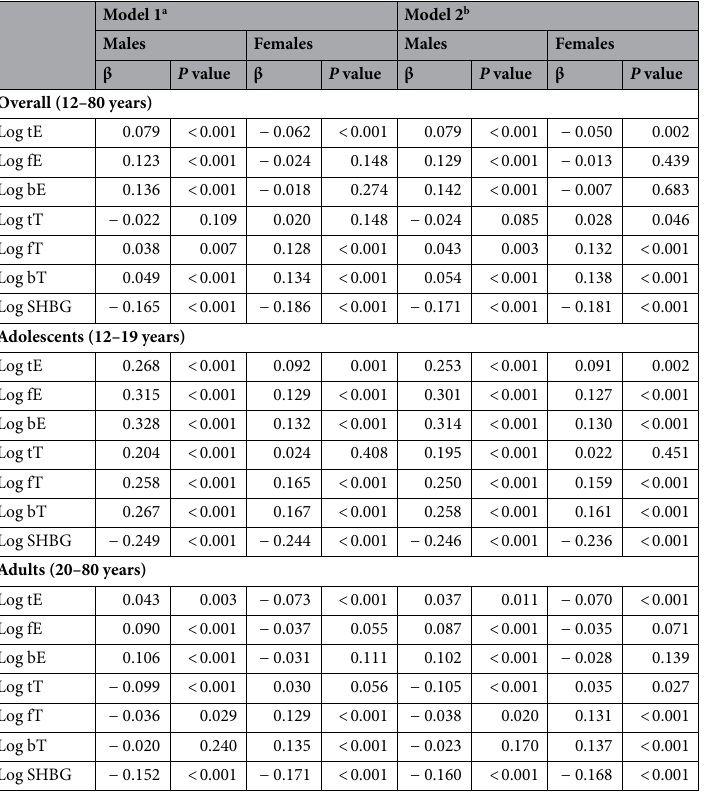
Table 3. Associations of log-transformed estradiol, testosterone, and sex hormone-binding globulin (independent variable) with uric acid (dependent variable) analyzed by weighted least squares regression. bE, fE or tE bioavailable, free or total estradiol; bT, fT or tT bioavailable, free or total testosterone; SHBG sex hormone-binding globulin. a Model 1: adjusted for age, ethnicity, body mass index (BMI, log-transformed), estimated glomerular filtration rate (eGFR), and self-reported health status, lifestyle confounders including smoking status, alcohol consumption, and physical activity. b Model 2: adjusted for all variables in Model 1 plus self-reported comorbidities including hypertension, diabetes, hypercholesterolemia, coronary heart disease, stroke, sleep disorder, gout, and cancer.